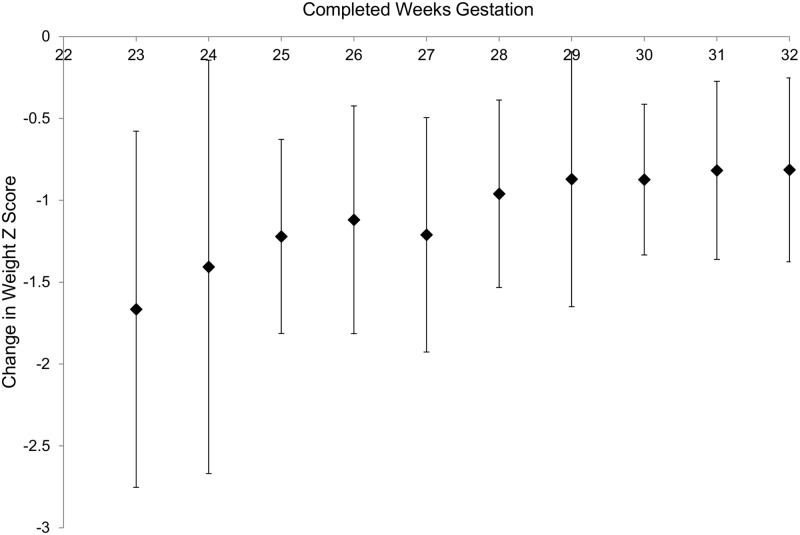
Change in weight Z score from birth to discharge (mean ± SD) vs. completed weeks gestation at birth for reference NICU (Mount Sinai).Regression line y = 0.066x-2.867, R2 = 0.063 (p<0.001).